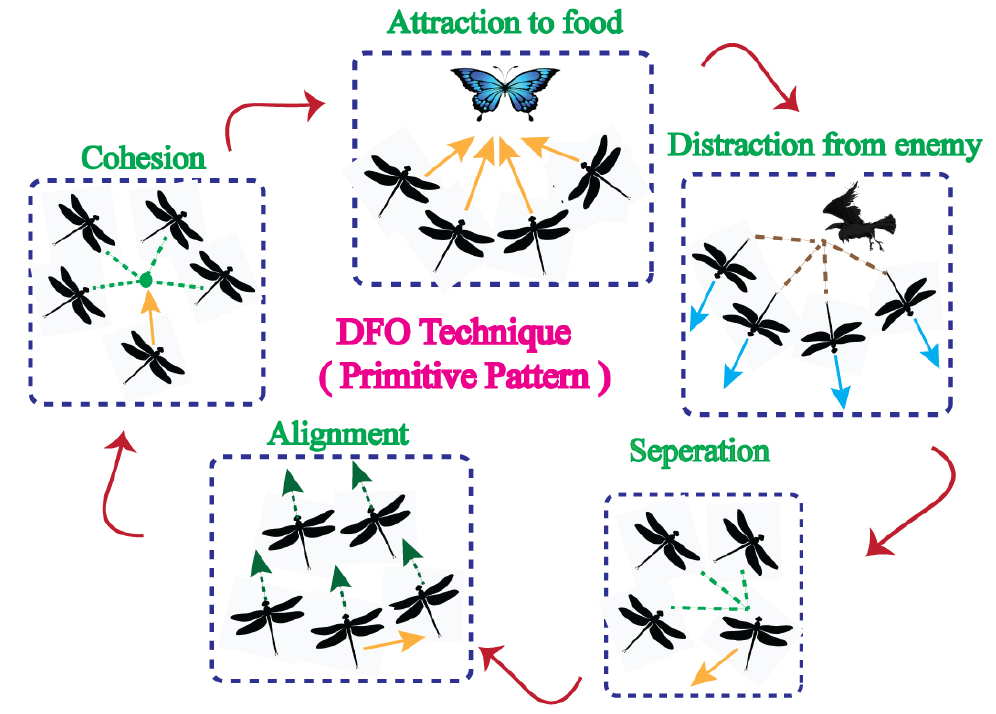
Figure 7. DFO technique primitive